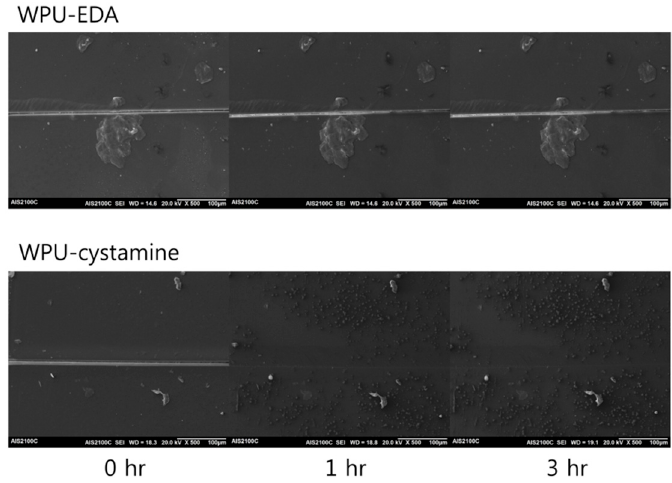
Figure 6. Scratch healing tests of WPU-EDA and WPU-cystamine at 130 ° С .